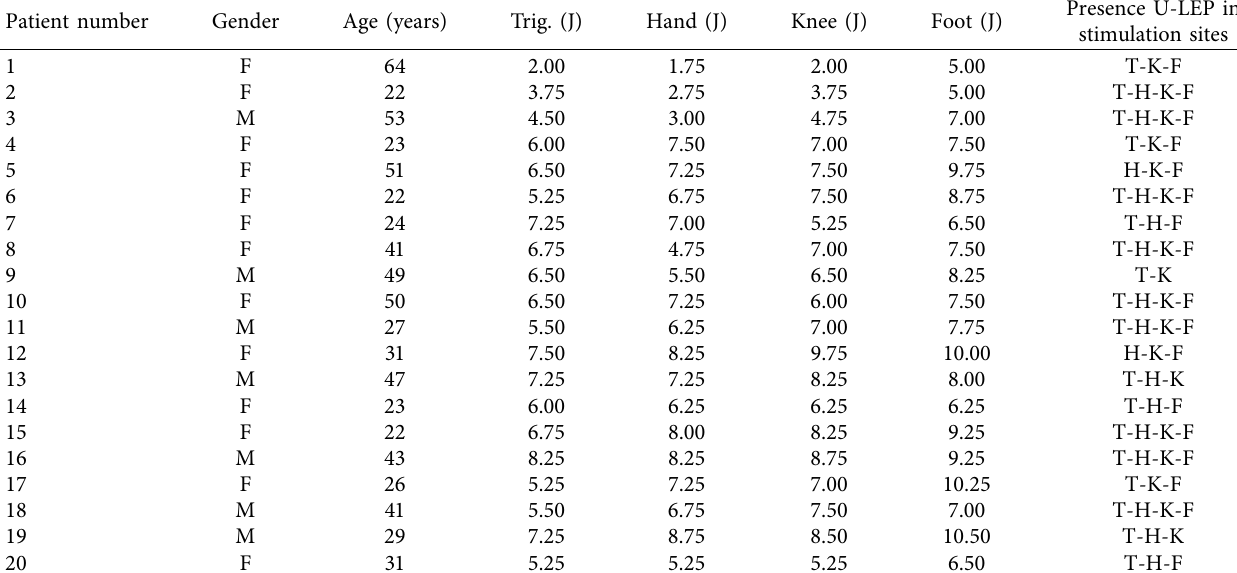
Table 2: Stimulation parameters of